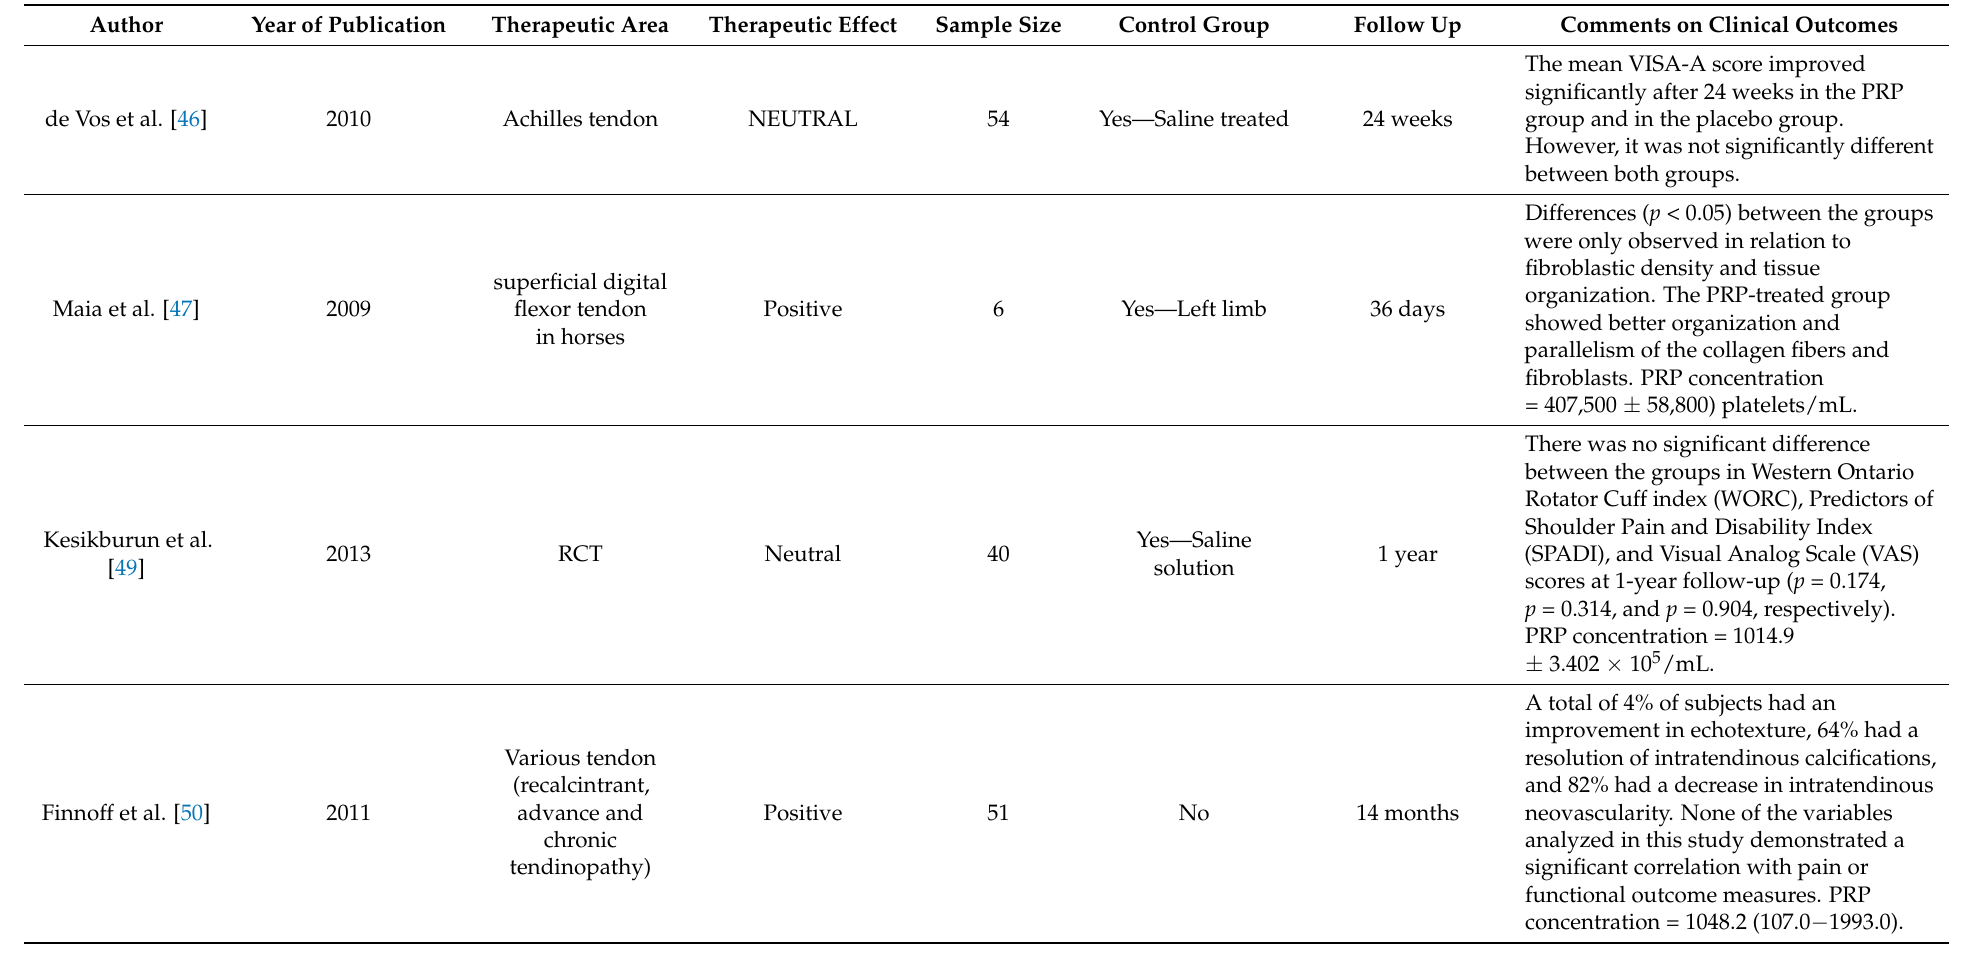
Table 2. Summarization of therapeutic area and clinical effects of PRP